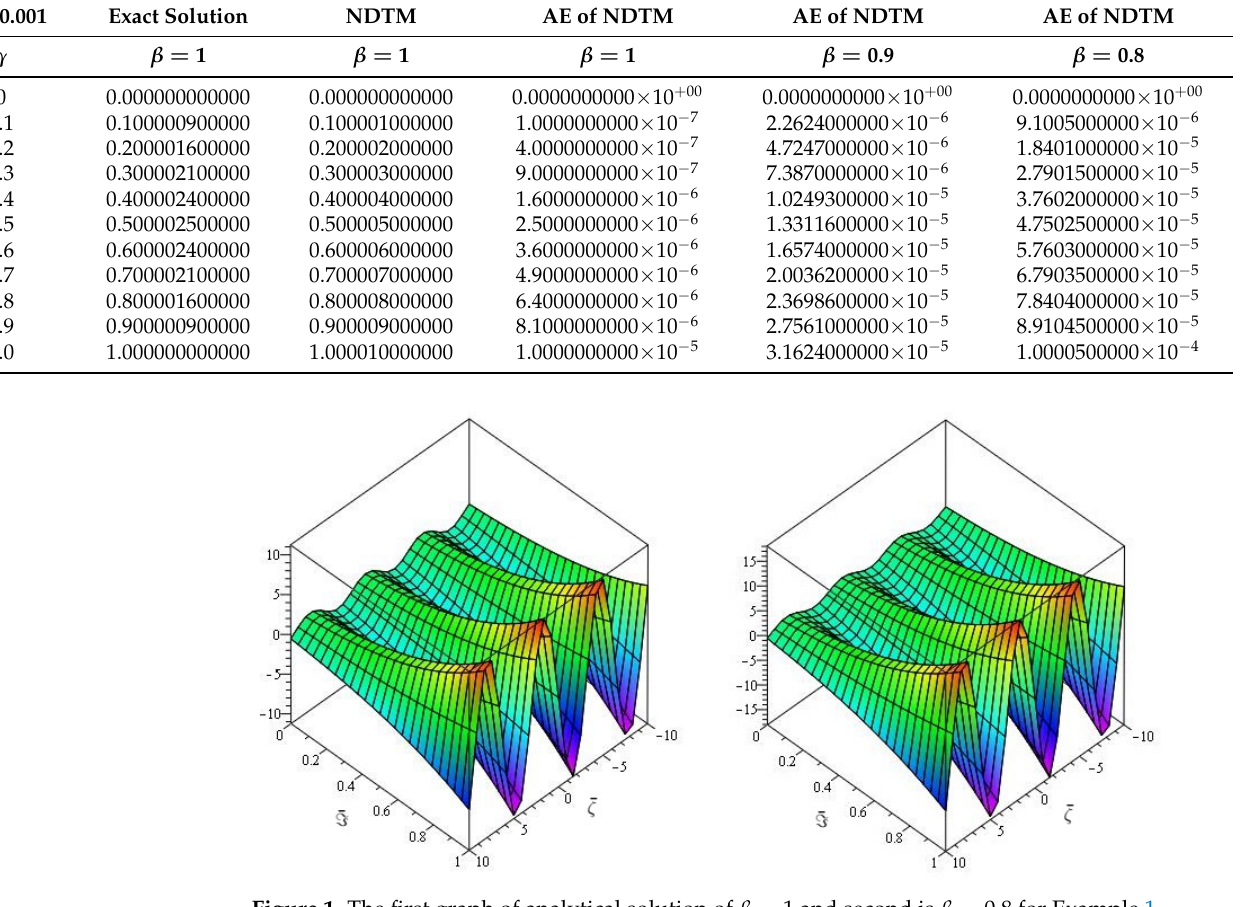
Figure 1. The first graph of analytical solution of β = 1 and second is β = 0.8 for Example 1.